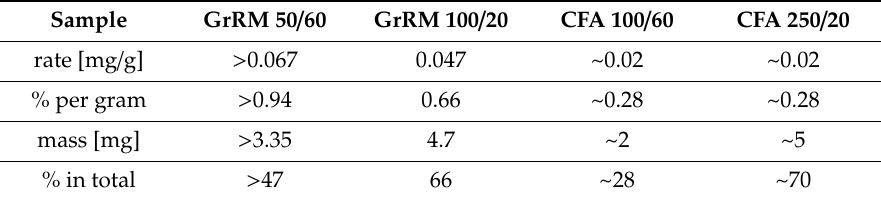
Table 8. Kinetics of zinc adsorption for Greek red mud and coal fly ash.